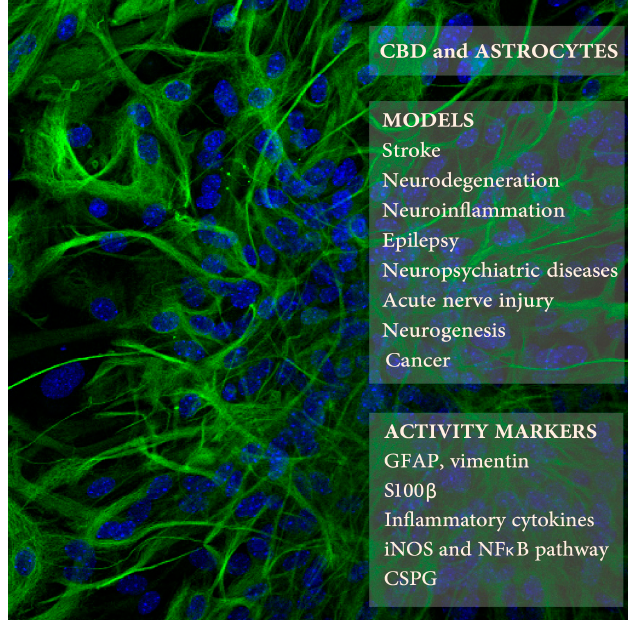
Figure 1. Cannabidiol (CBD) effects on astrocytes was studied in several animal models of neuropathologies (upper right frame) using selected markers of astrocyte activity (lower frame). The background picture presents mouse astrocytes in culture expressing glial fibrillary acidic protein (GFAP) (in green; blue color indicates cell nuclei; Kozela, Juknat, and Vogel, unpublished data).